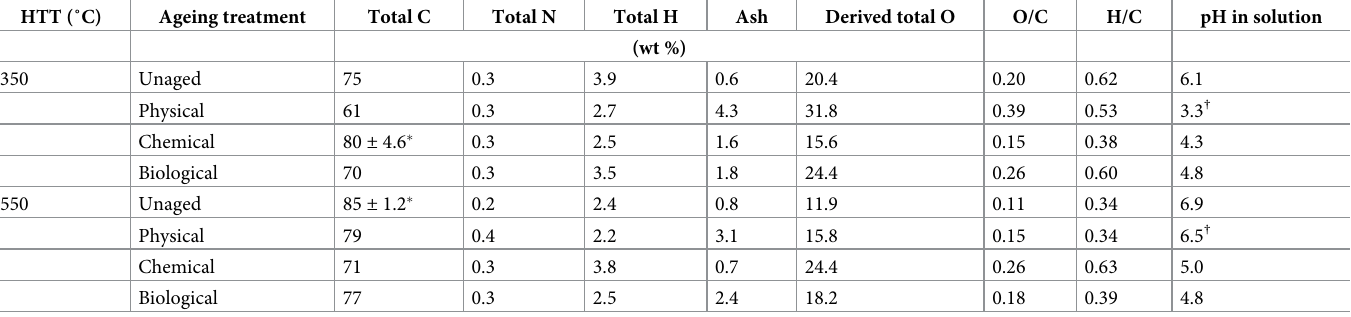
Note: Data shown represent the mean of all lab replicates unless specified otherwise. � Mean ± standard deviation is shown for data where the standard deviation of lab replicates (N = 4) is > 1. † No replicate measurements were included due to sample